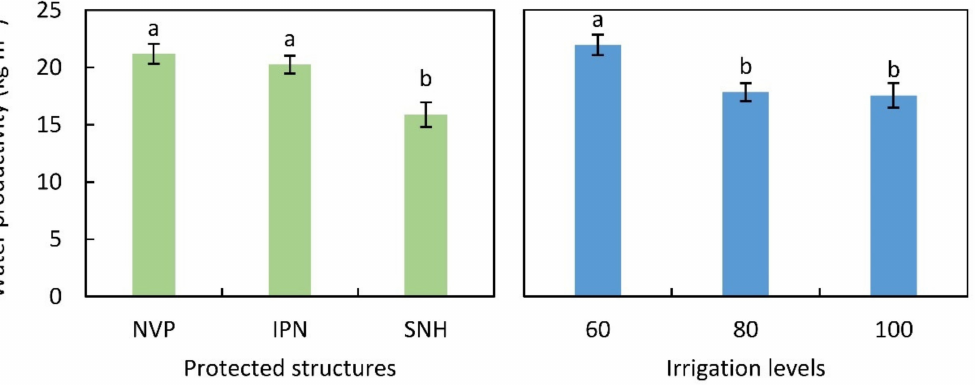
Figure 3. Water productivity (kg m − 3 ) of tomato in different protected structures ( left ) and irrigation levels ( right ). Mean values followed by the same letter are not significantly different within each factor at p ≤ 0.05 according to DMRT. NVP, Naturally ventilated polyhouse; IPN, Insect-proof net house; and SNH, Shade net house. Irrigation levels 100, 80 and 60 correspond to 100%, 80% and 60% of